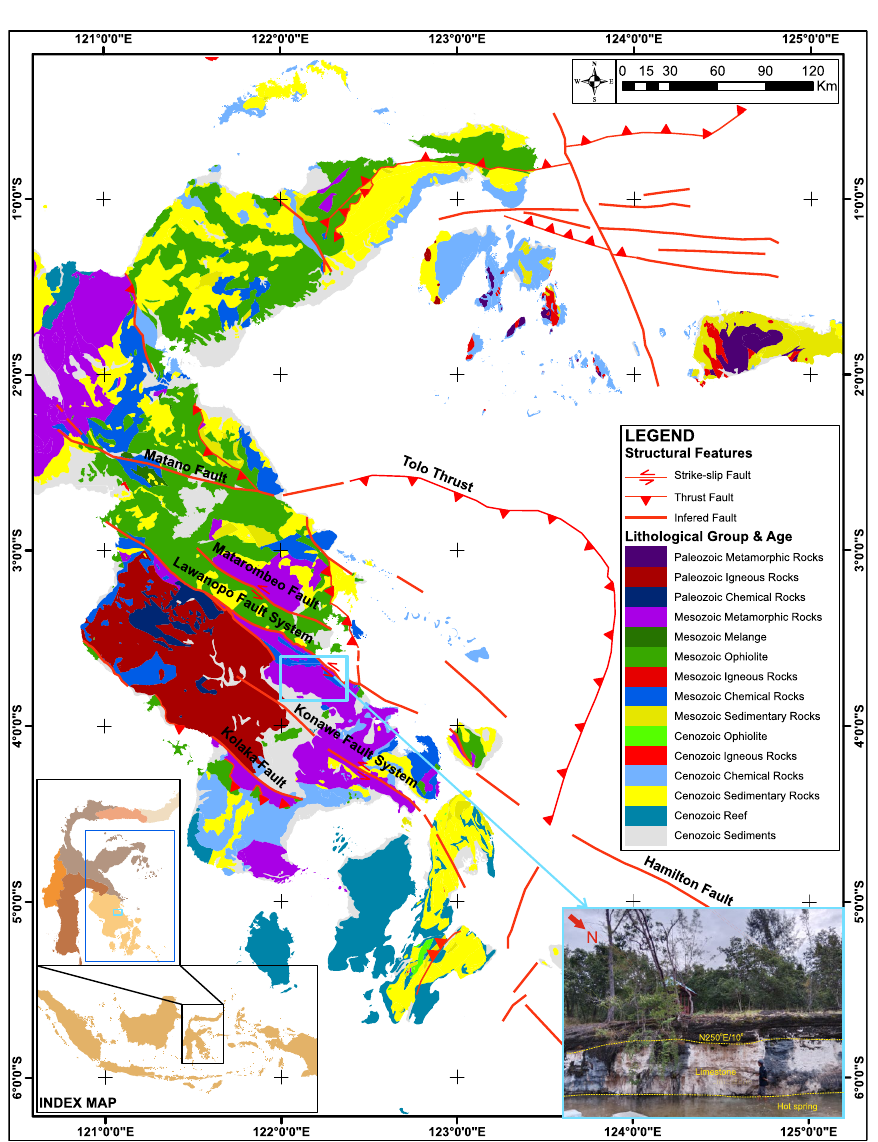
Fig. 2 Map showing the Lawapono fault system in the southeast Sulawesi (Simandjuntak et al. 1993; Martosuwito 2012; Surono and Simandjuntak 1993; Tjokrosapoetra et al. 1993). Blue rectangle outlines the study